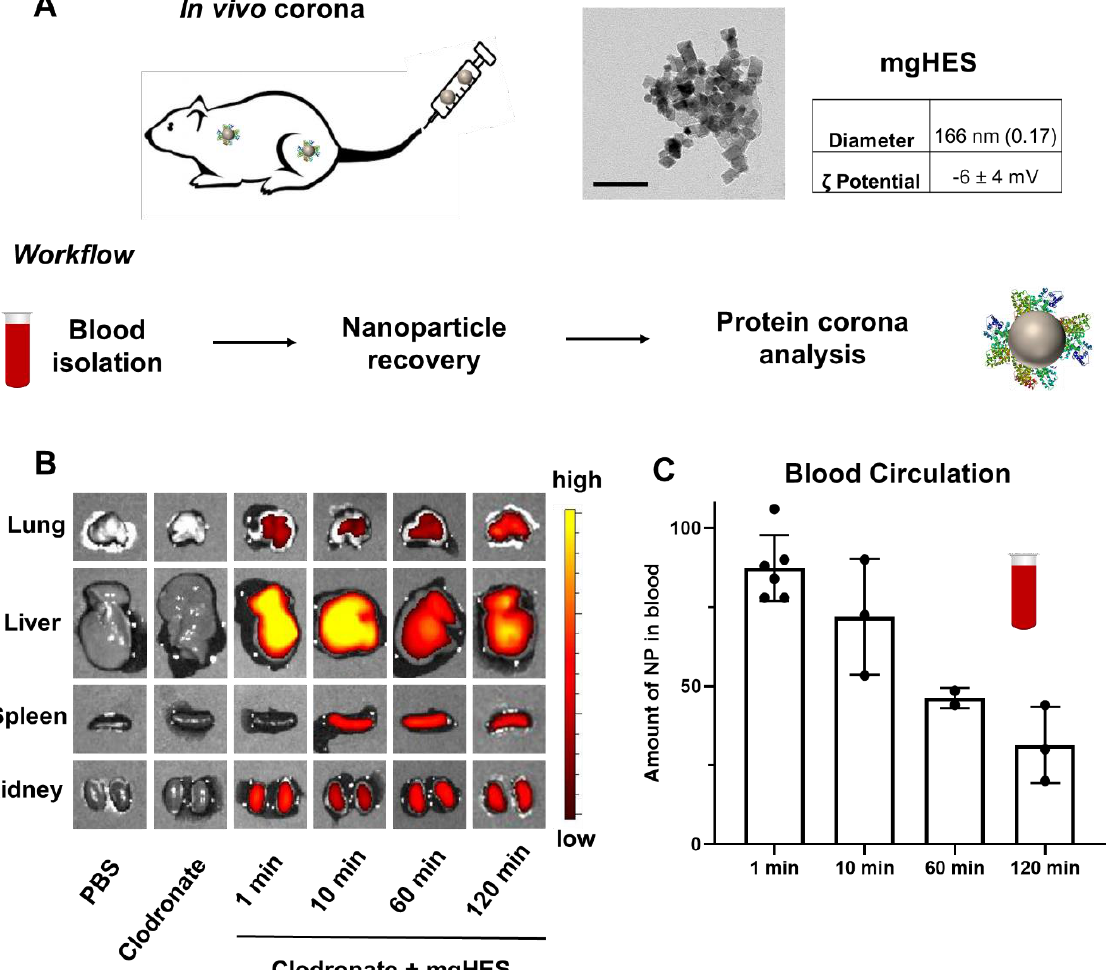
Figure 1. Monitoring the biodistribution and blood circulation of magnetic HES nanoparticles in vivo. ( A ) Magnetic HES nanoparticles (mgHES) were injected into mice and the blood was isolated after distinct time points (1 min–2 h). Nanoparticles were recovered from the blood via magnetic separation and further the protein corona surrounding nanoparticles after in vivo circulation was analysed. ( B ) A representative IVIS image of the different organs after treatment with PBS and clodronate-liposomes as control or mgHES nanoparticles. ( C ) The nanoparticle concentration in blood after distinct time points was measured via a Tecan Plate Reader and normalized based on the initial injected amount of nanoparticles ( n = 2–6).